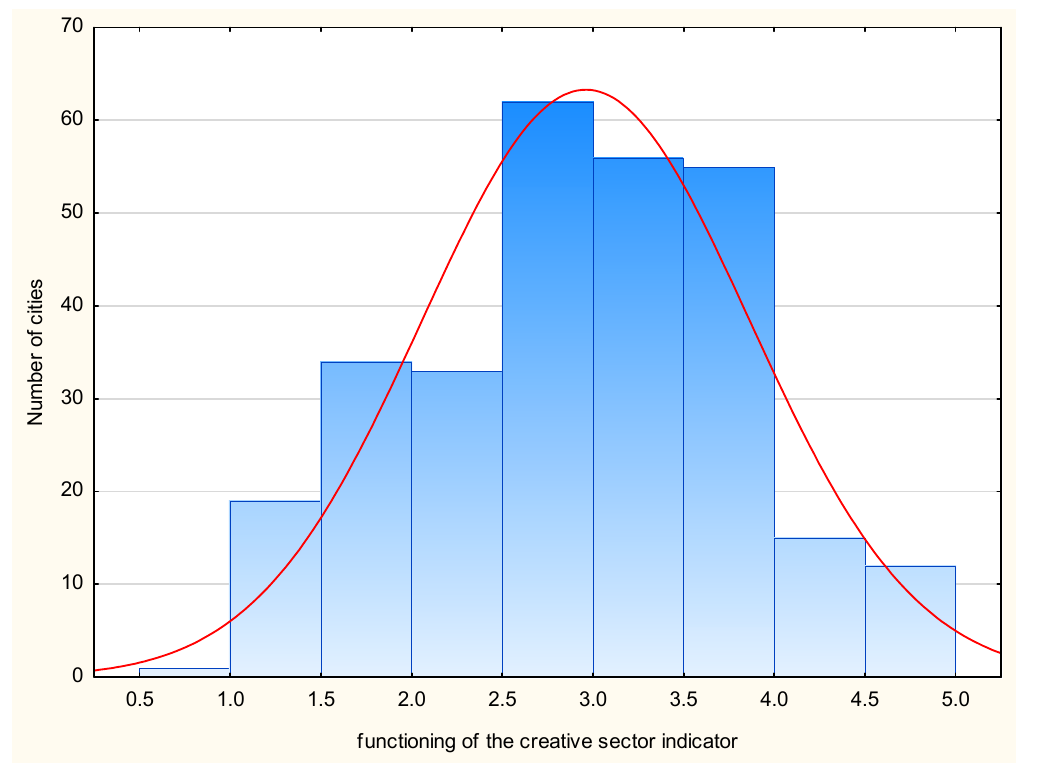
Figure 2. Histogram for the variable functioning of the creative sector indicator. Source: Author’s own research.